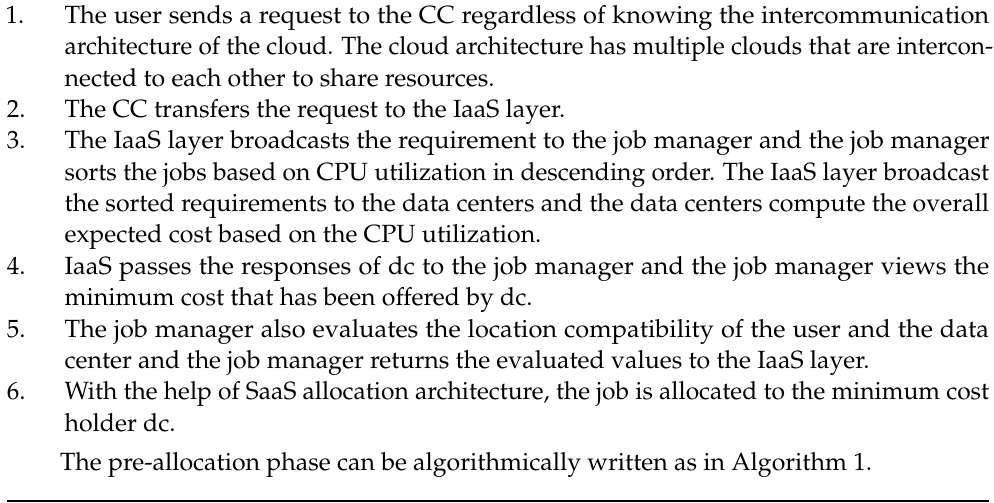
Algorithm 1: Preliminary